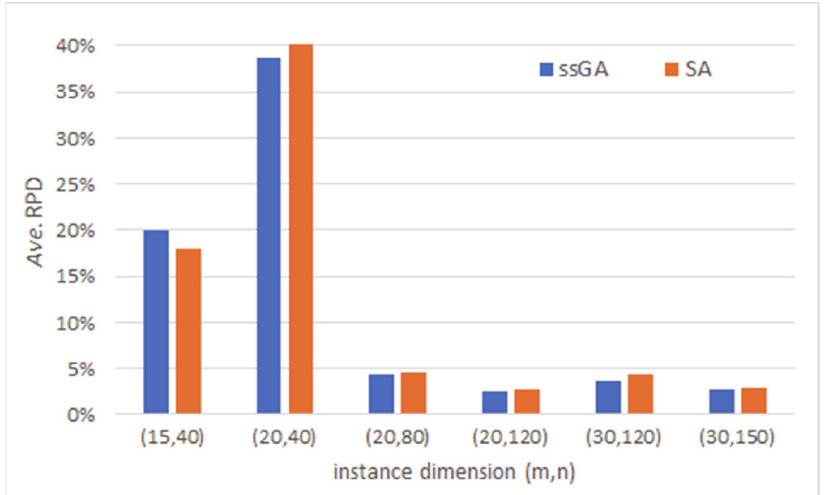
Fig. 1. Ave. RPD ssGA results for ssGA in PFS problem variant and SA in NPFS problem variant, considering a 5% of zero values in the processing